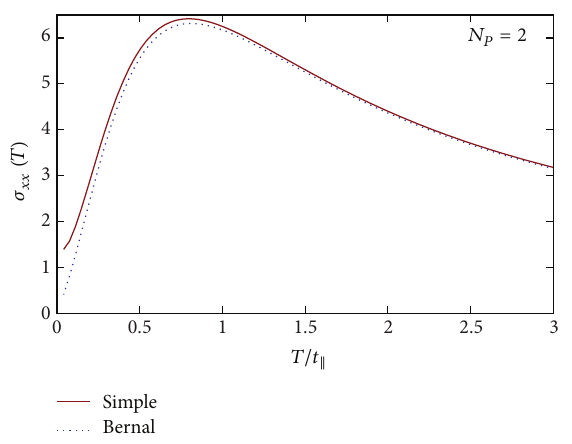
Figure 4: Comparison of the FEC of the bilayer graphene for simple and Bernal cases. The interplane hopping term is 𝑡 ⊥ = 𝑡 ‖ /7